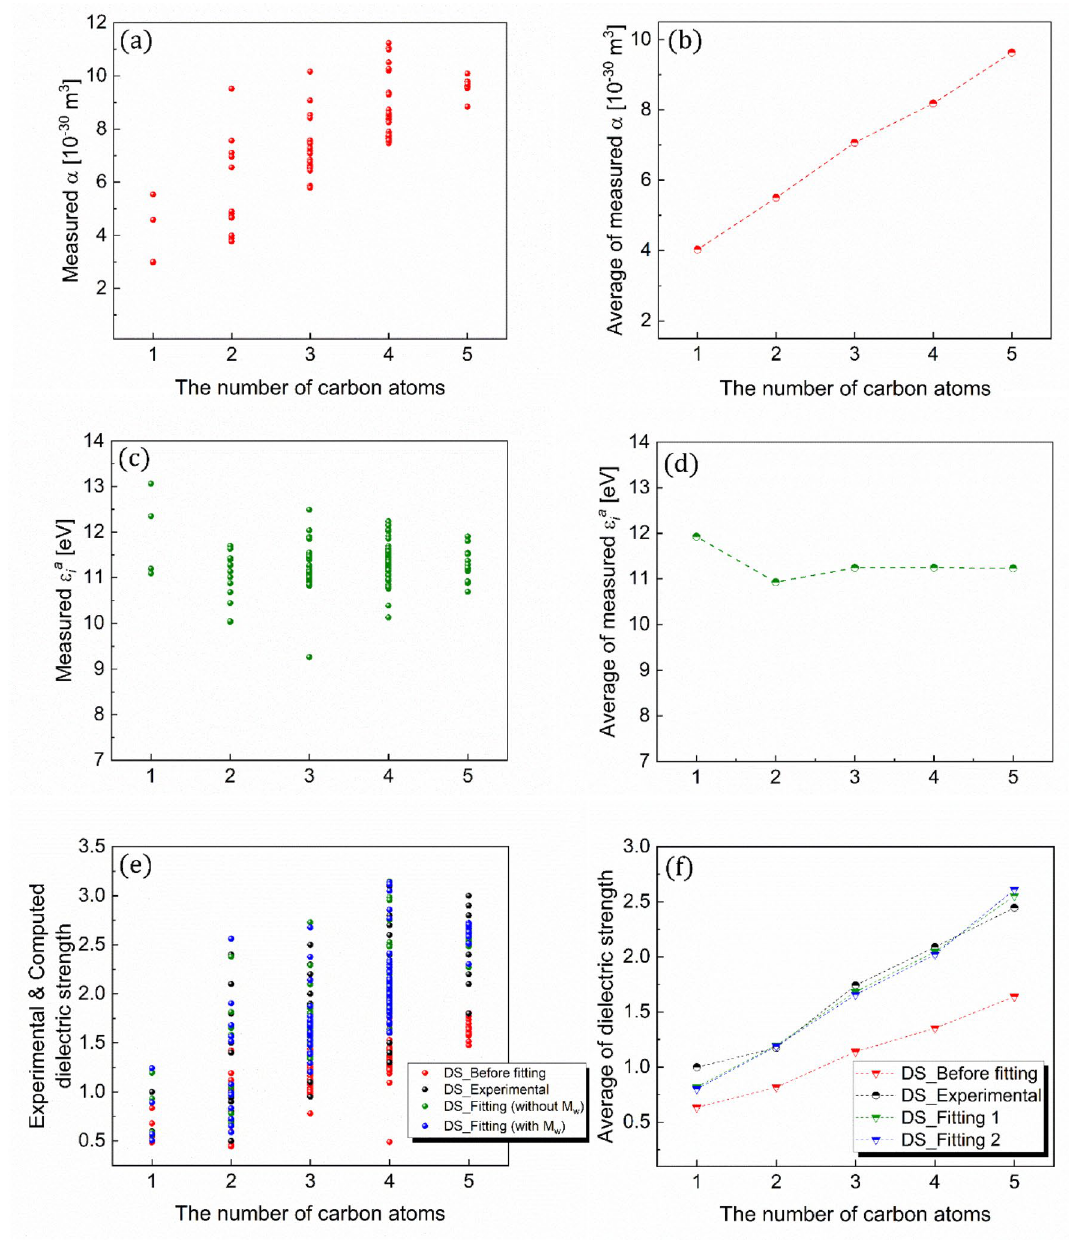
Figure 10. Correlations with structural property. ( a , b ) Polarizabilities, ( c , d ) ionization energies, and ( e , f ) dielectric strengths of the organic compounds correlated with their numbers of carbon